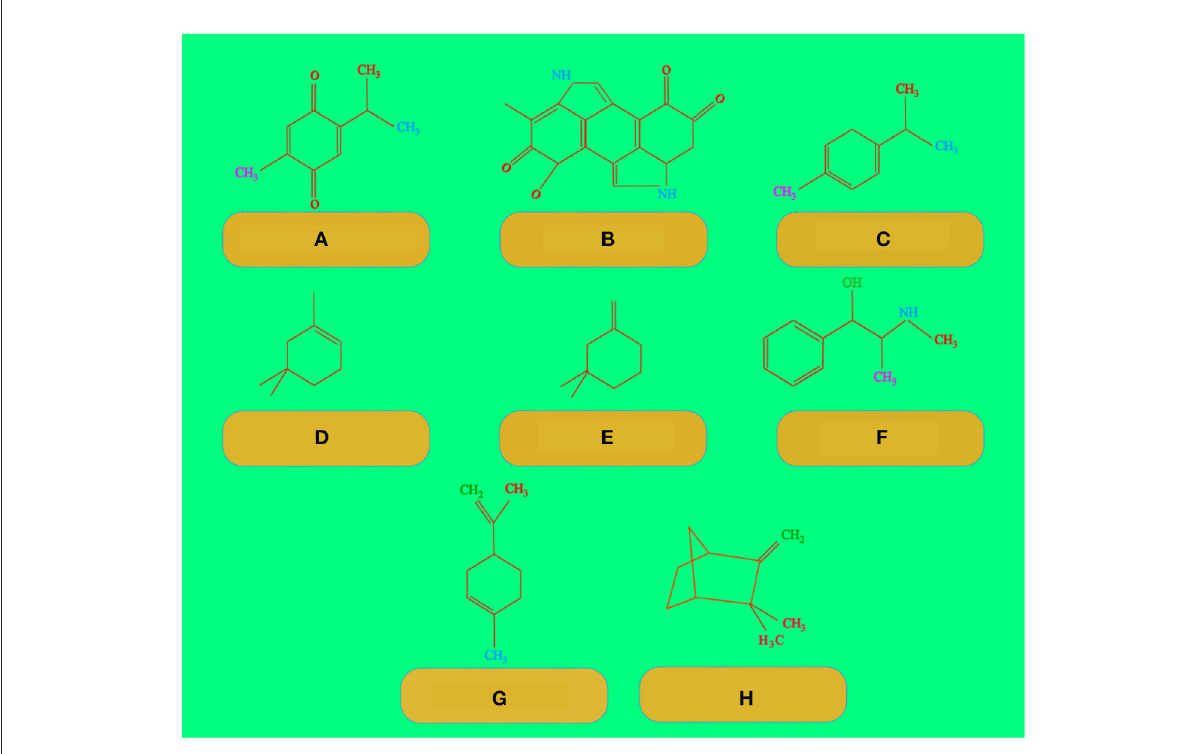
FIGURE3 Chemical structures of (A) thymoquinone, (B) melanin, (C) P-cymene, (D) a-pinene, (E) b-pinene, (F) alkaloid, (G) limonene, and (H) camphene.